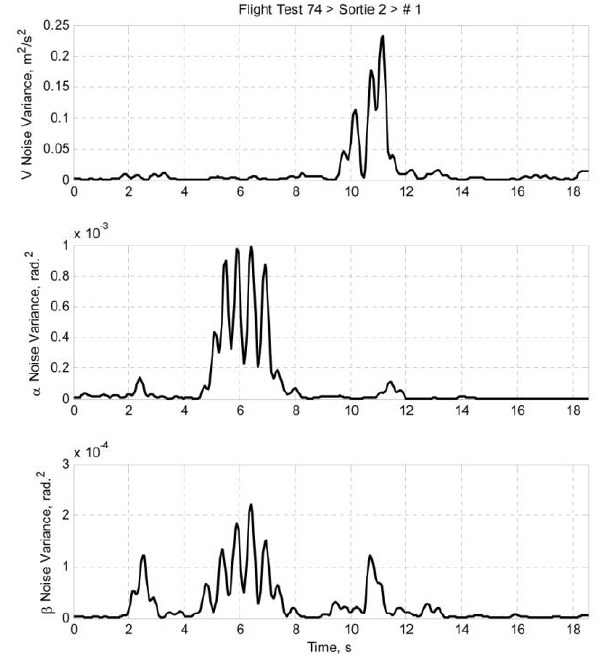
Figure 9. Airdata noise variance of ft74srt02run01.